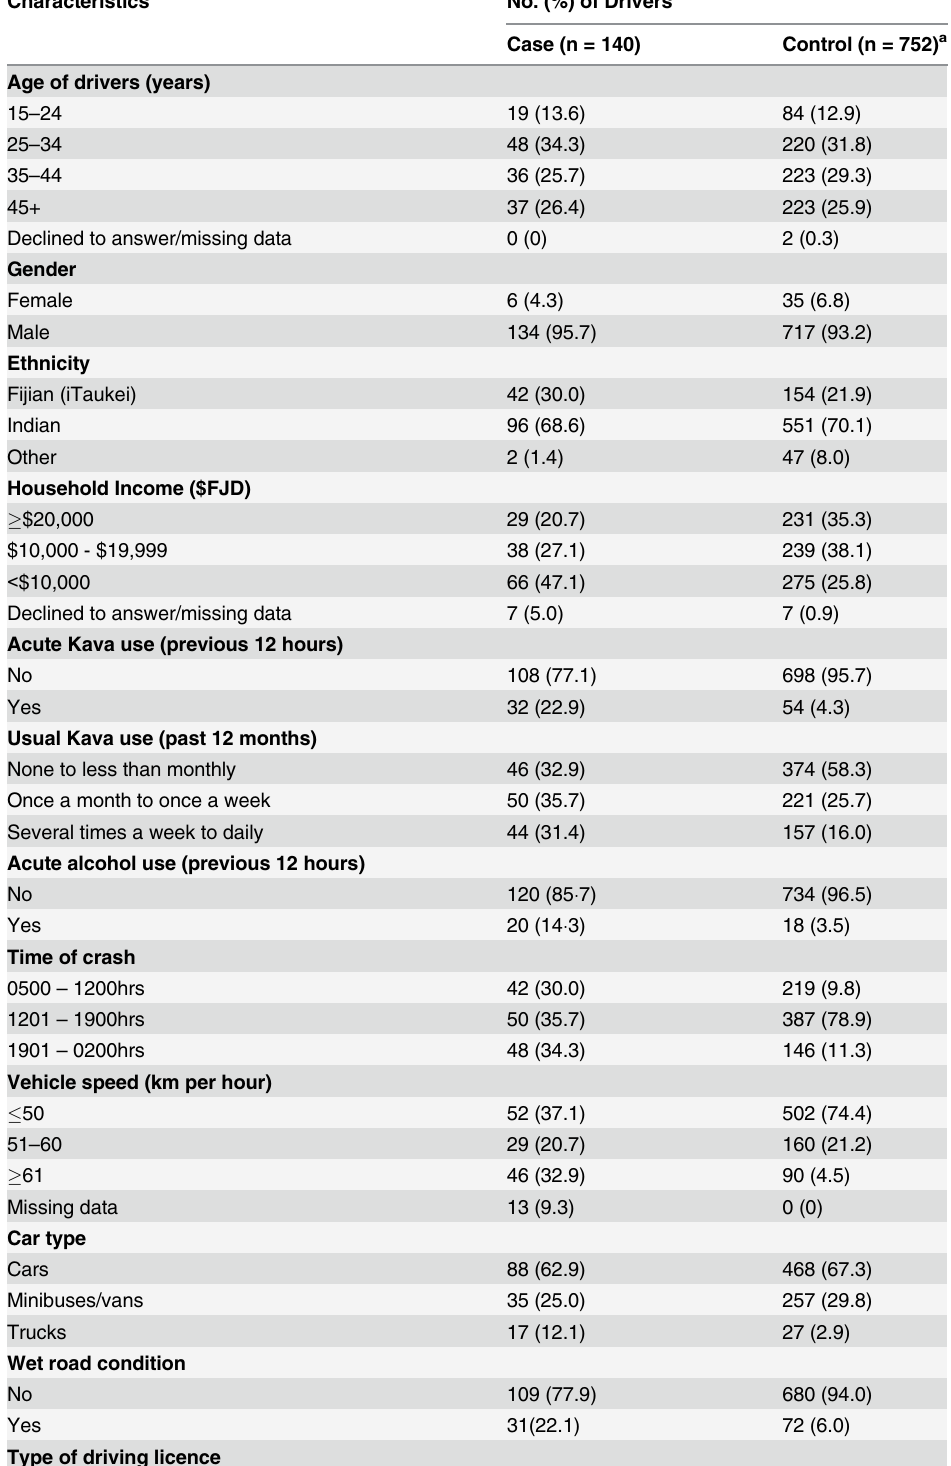
Table 1. Distribution of kava consumption and potential confounders for cases and controls, Fiji, 2006.